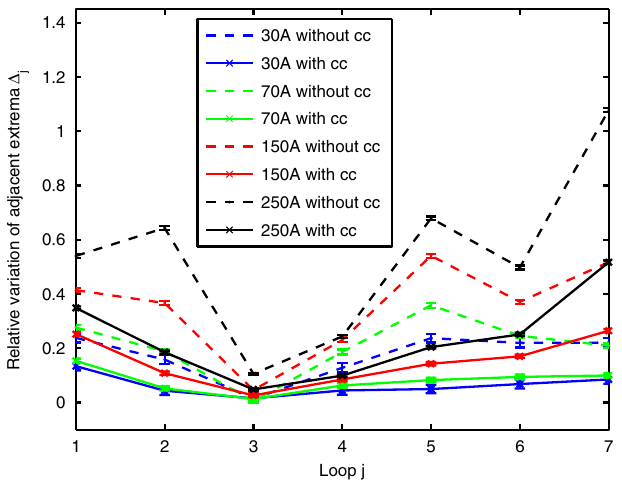
FIG. 10. (Color) Ratio of the absolute values of adjacent ex- trema with and without the YBCO loop system for the different A j; max jj with the loop num- currents I main of Table I. (cid:1) j ¼ j 1 (cid:3) j A j; min ber j . The values at the beginning and the end are higher due to the finite length of the induction-shimming